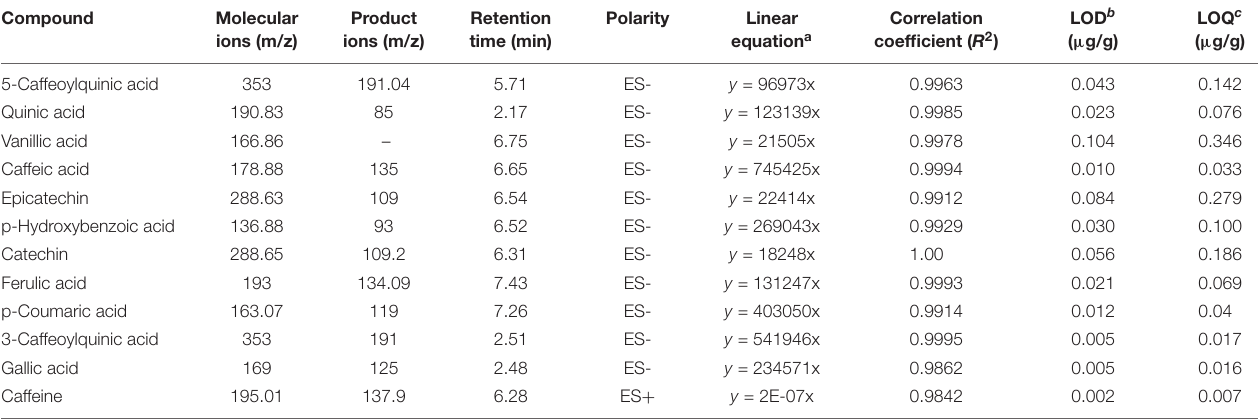
TABLE 2 | Molecular and product ions, retention times, linear correlation coefficients, LOD, and LOQ of anti-inflammatory compounds identified in spent coffee ground extracts. Compound